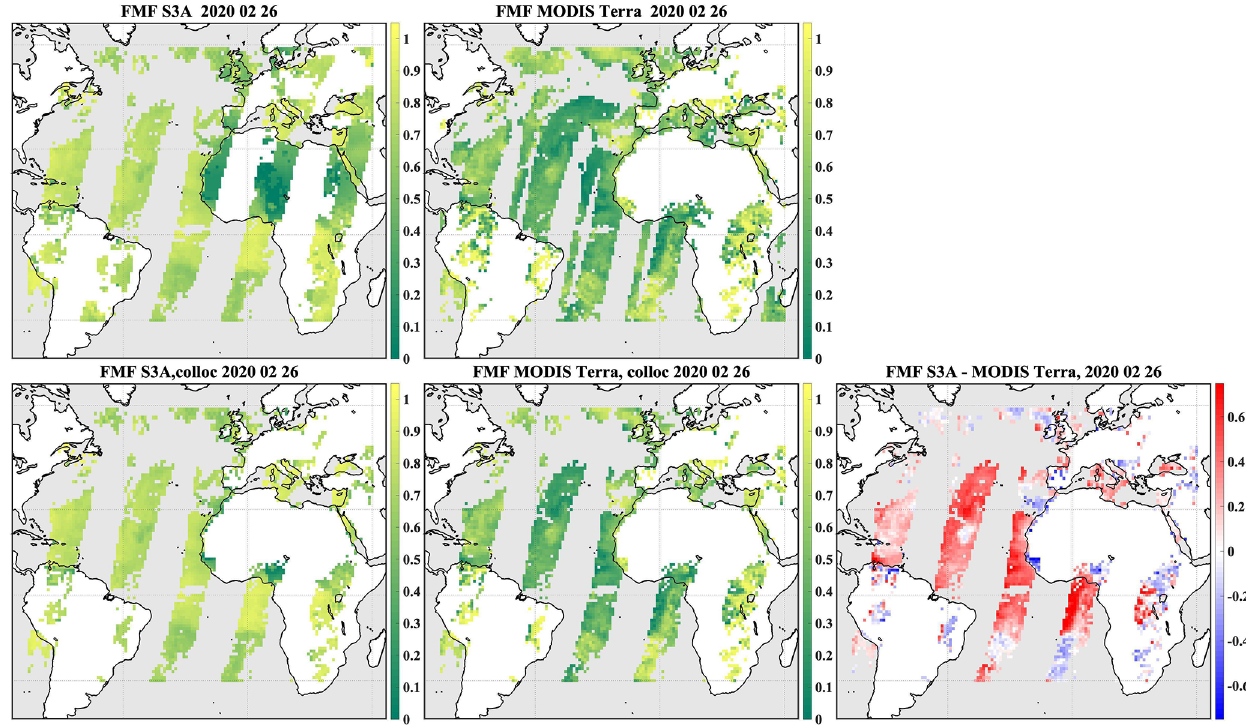
Figure 28. Same as Fig. 27 for syFMF; all pixels available in S3A FMF (a) and MODIS FMF (b) products. Pixels existing in both products (collocated products), S3A FMF (c) and MODIS FMF (d) , as well as the difference between S3A and MODIS FMF (e)